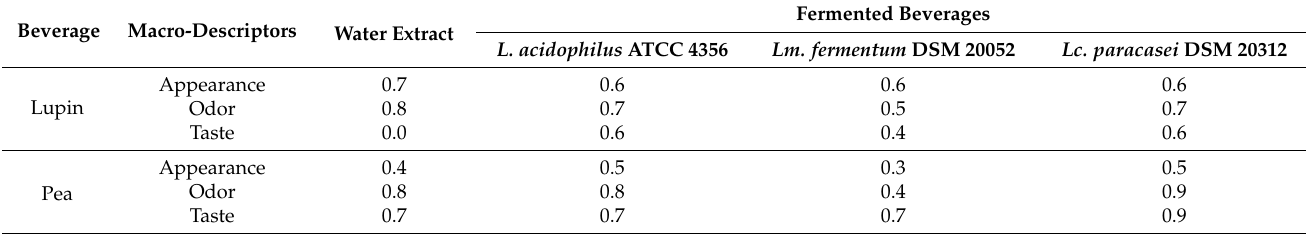
Table 10. Comparison between acceptability scores of macro-sensory descriptors of fermented legume grain beverages and unfermented water